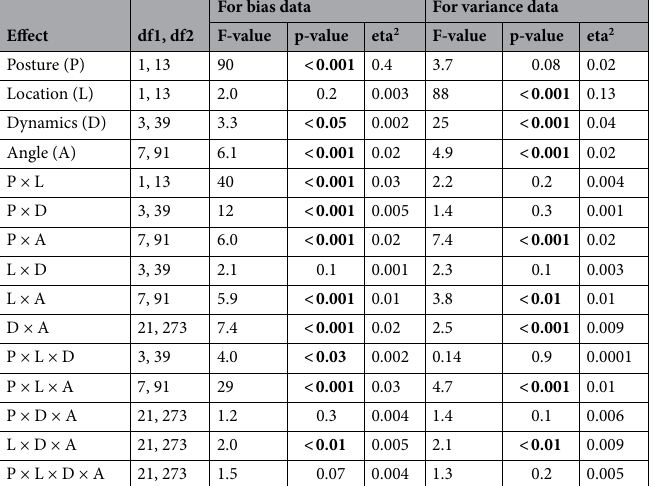
Table 3. Results from the ANOVAs of Experiment